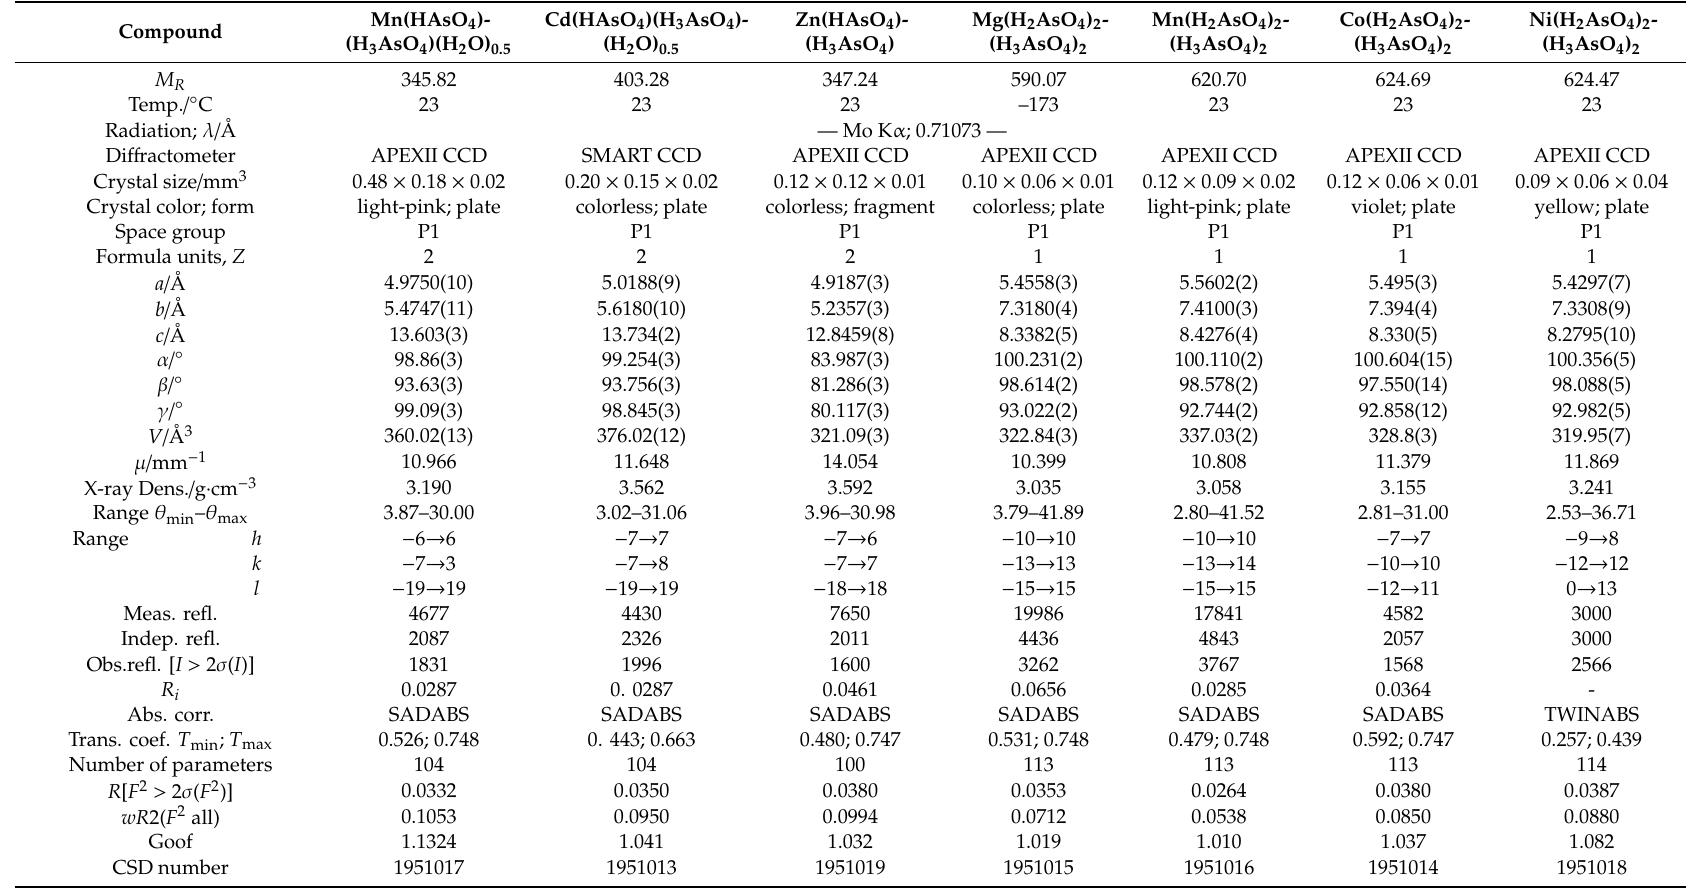
Table 3. Details of X-ray data collections and crystal structure